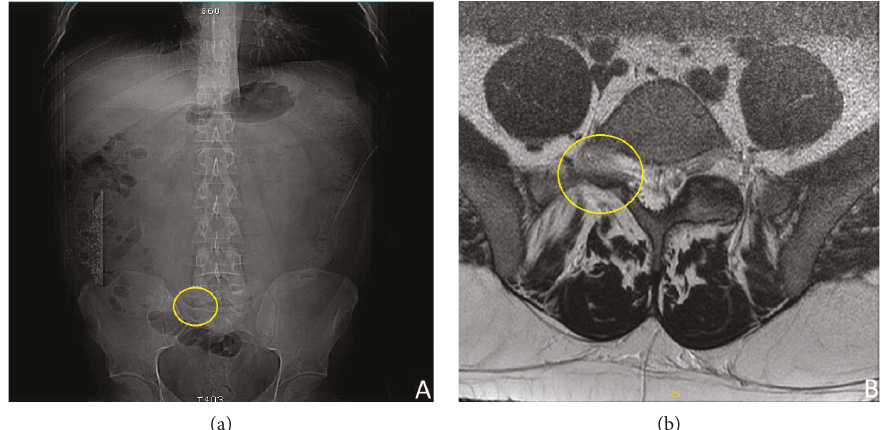
Figure 1: (a) Scout X-ray image showing the absence of the right L5-S1 zygapophyseal joint. (b) On axial spine MRI, the right articular process of S1 is absent, with the inferior articular process of the L5 markedly hypoplastic.